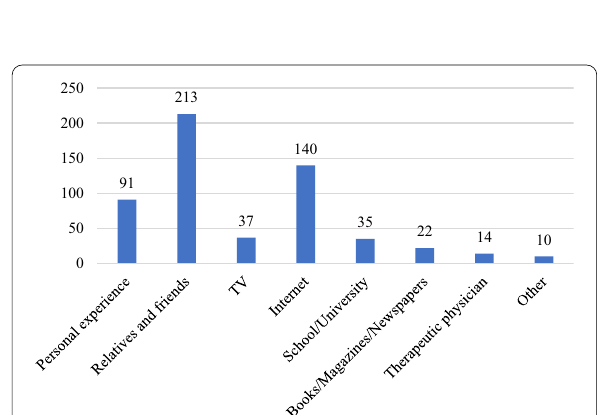
Fig. 5 Main sources of information about migraine for the